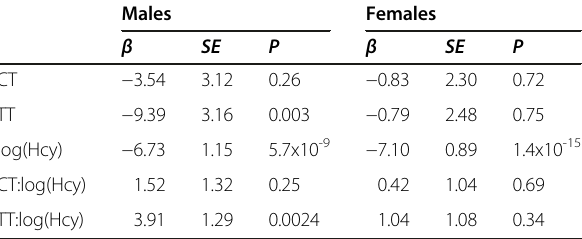
Table 4 Regression analysis of eGFR with interaction between homocysteine and MTHFR C677T